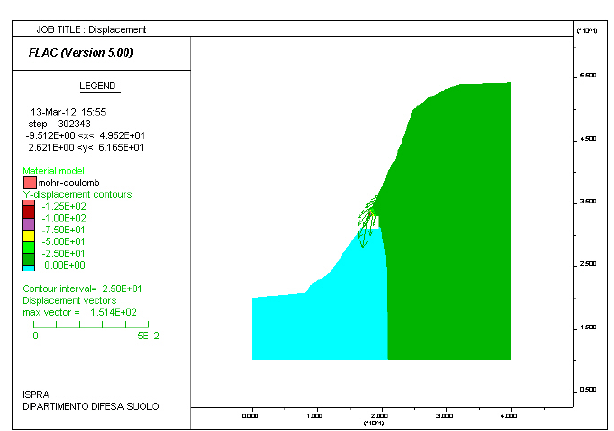
Fig. 11. Section 1. Displacement vectors in the pre-collapse move- ments. The simulation includes the presence of a cave in the sec- tion. The resulting collapse mechanism is definitely linked to the collapse of the vault of the cave. The simulation process stops for an excessive deformation that distorts the computing grid beyond the accepted